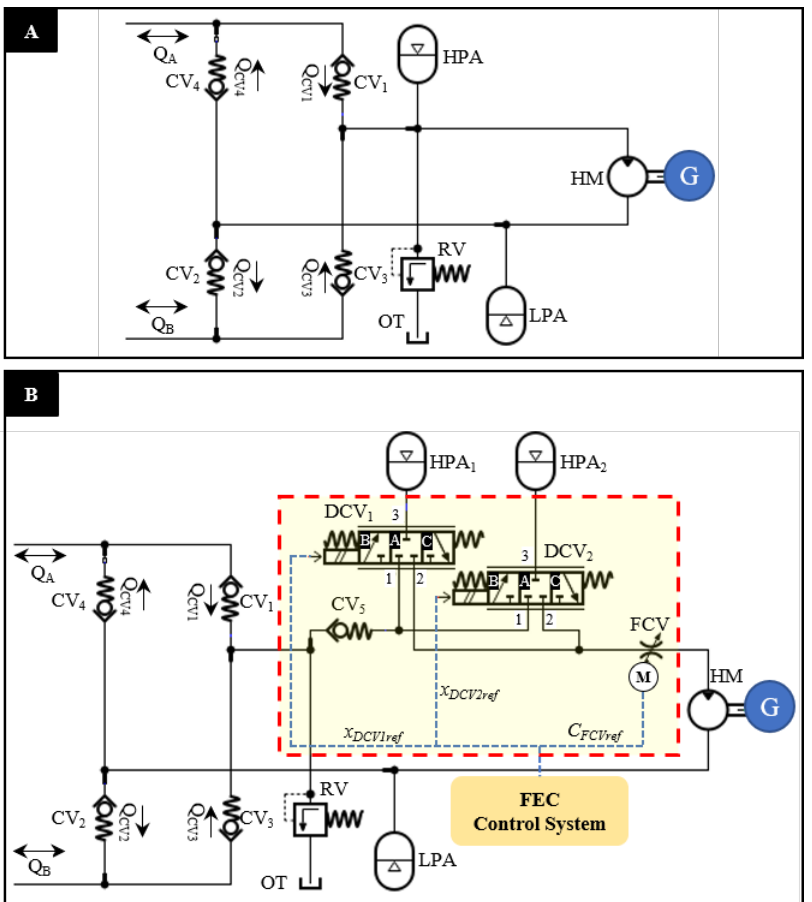
Figure 2. Schematic diagram of HPTO unit concepts. ( A ) Conventional HPTO unit from [22] and ( B ) an improved HPTO unit proposed in the present